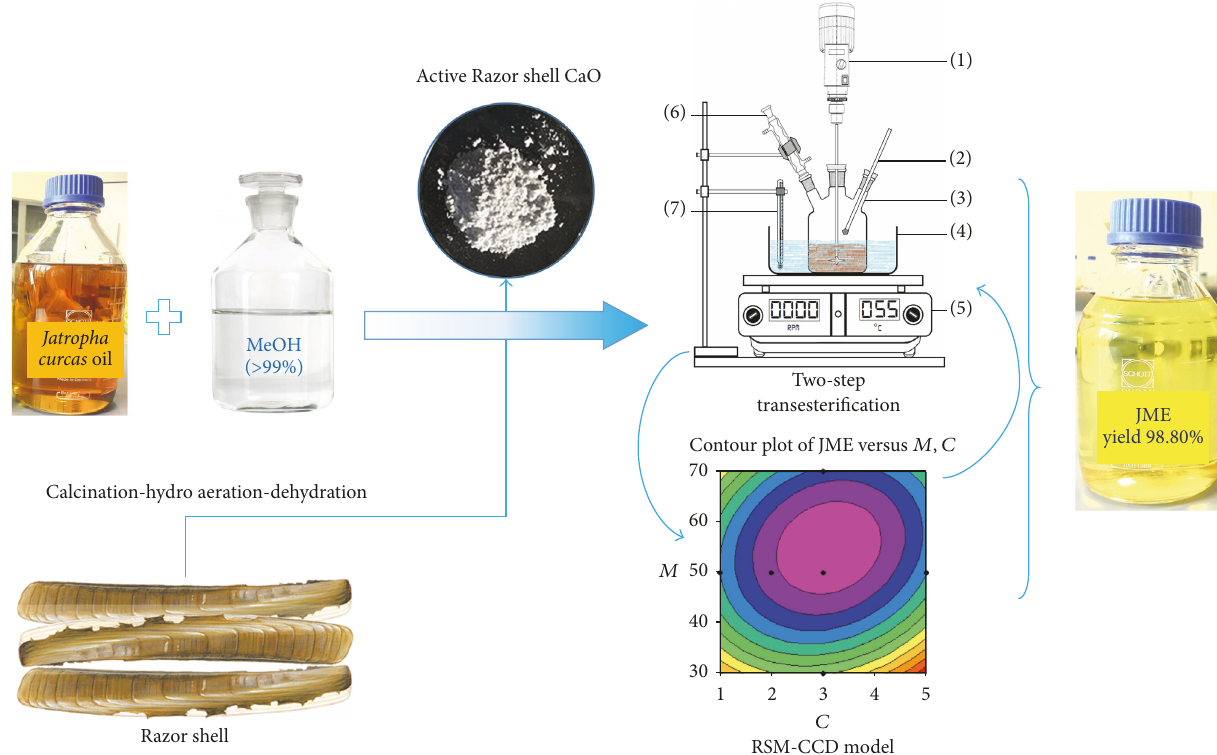
Scheme 1: Jatropha methyl ester production optimization using active Razor shell CaO